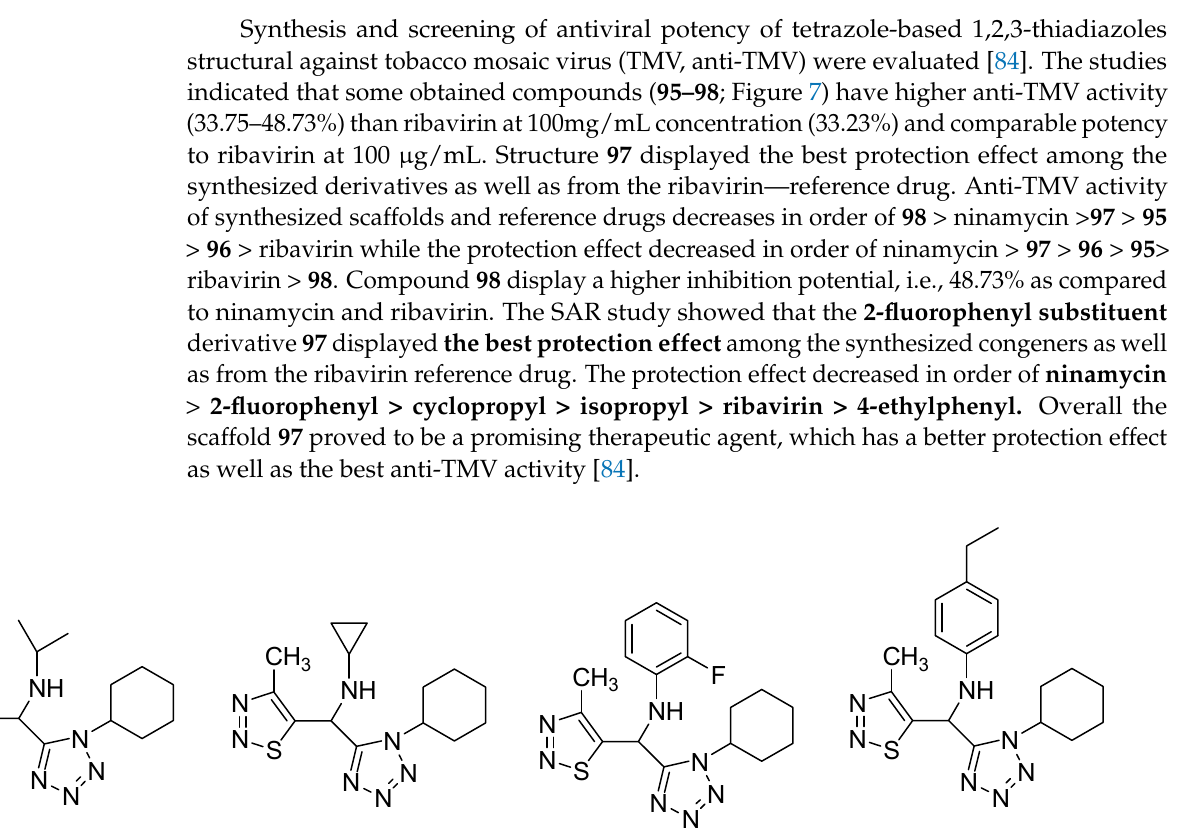
Figure 7. Antiviral activity of terazole derivatives 95–98 .